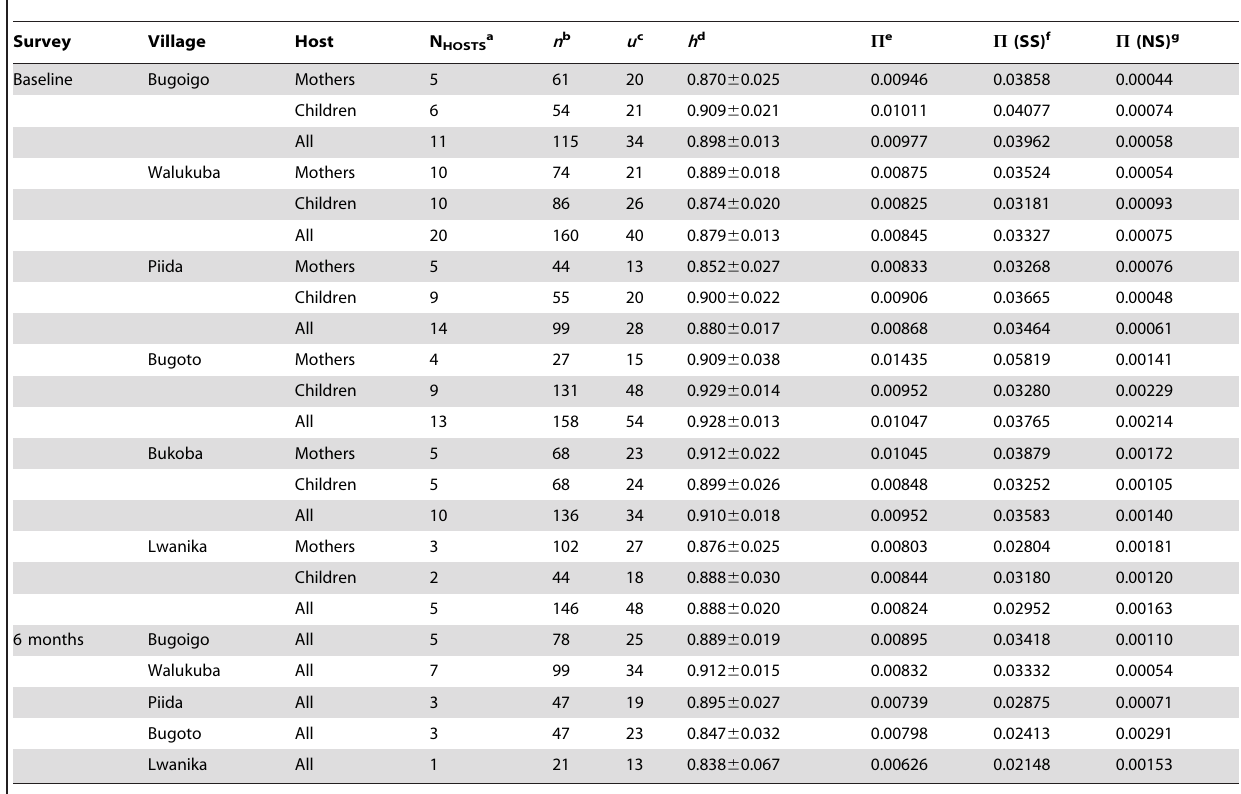
Table 2. Cox 1 diversity stratified by host type and village at baseline and 6 months.